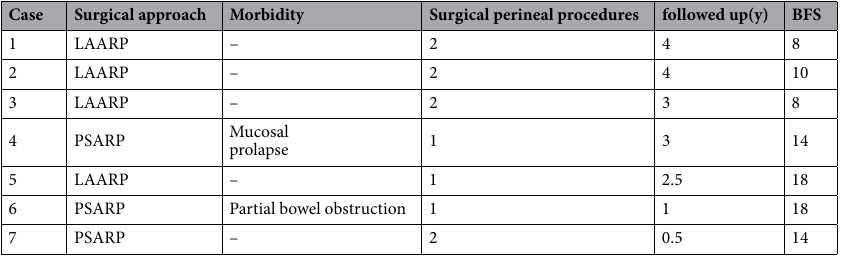
Table 2. Clinical features of patients with